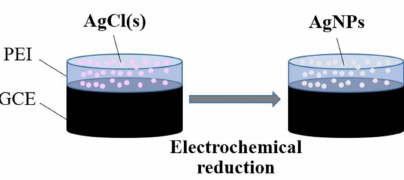
Figure 7. Schematic representation of the fabrication process of AgNPs /